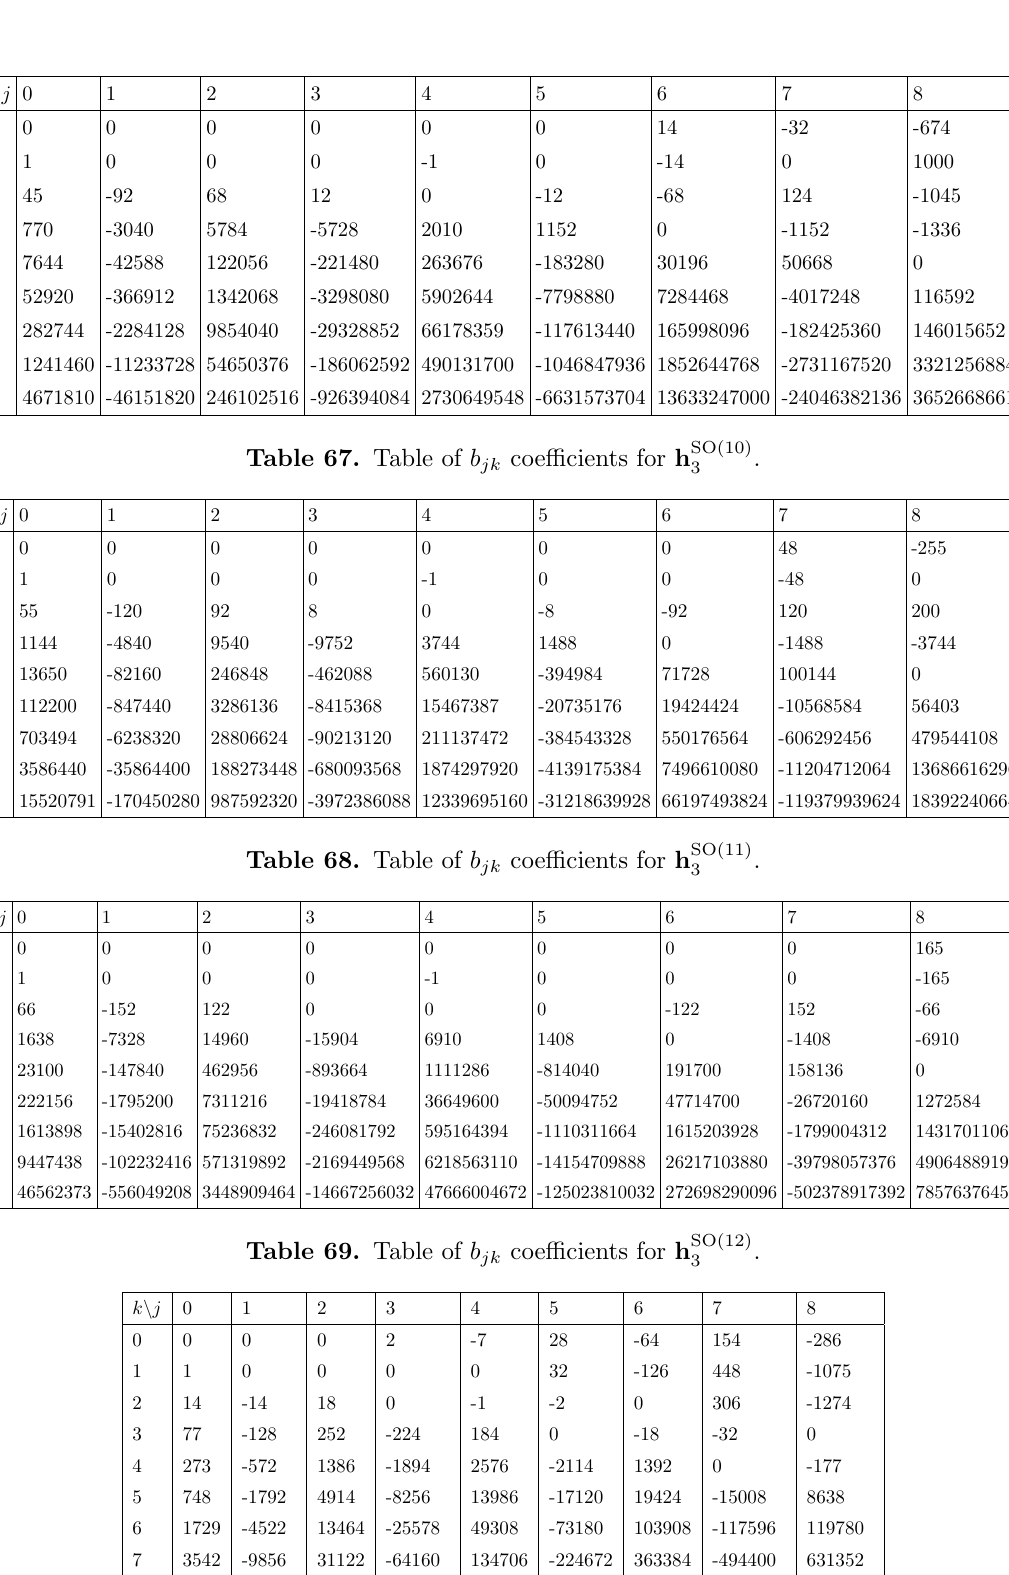
Table 70. Table of b jk coe(cid:14)cients for h G 2